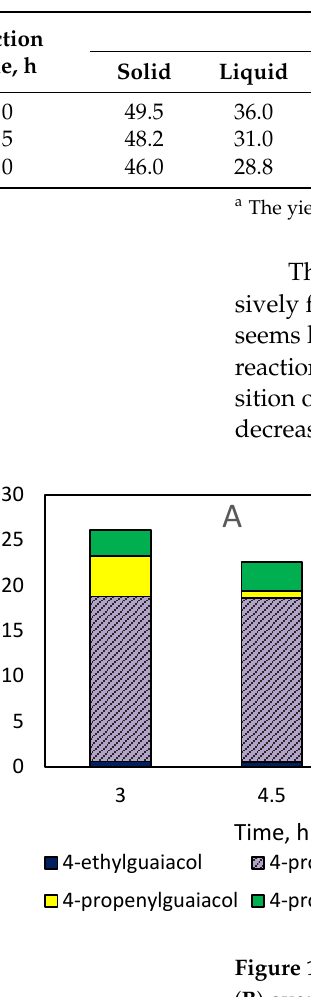
Table 7. The effect of time of spruce wood RCF at 225 °C over the 3RS450 catalyst on the products yield and composition.